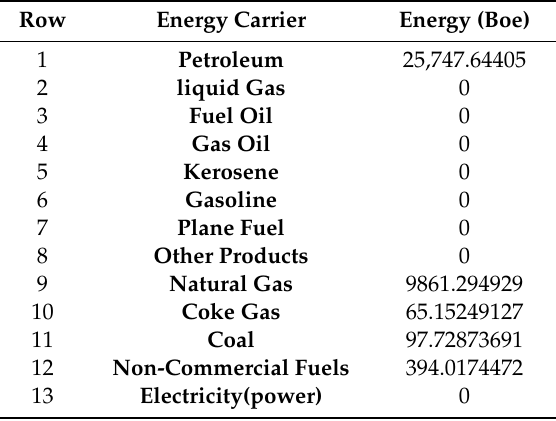
Table A5. Domestic supplies of energy